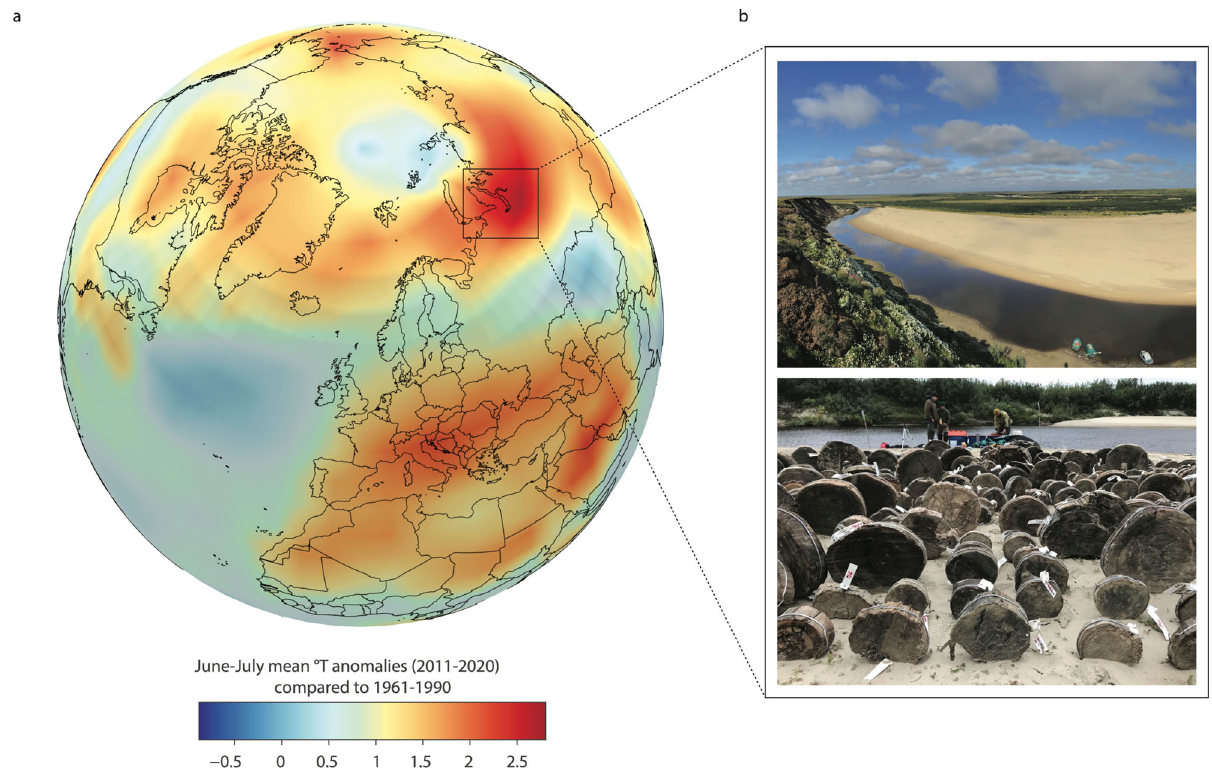
Fig. 1 | Study region and sampled material. a Mean June – July temperature anomalies over the Northern Hemisphere and the larger Yamal Peninsula region (black rectangle) over the last decade on record (2011 – 2020). Temperatures are expressed as anomalies relative to a 1961 – 1990 baseline climate using the